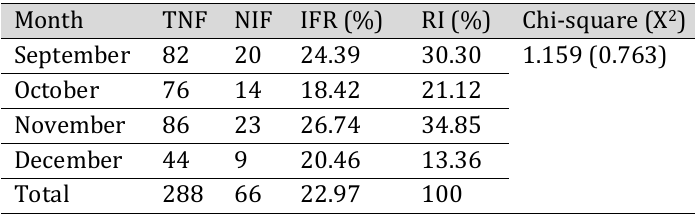
Table 1. Monthly distribution of parous-infected Simulium damnosum at the Kaduna river banks along Yakowa Express Road.